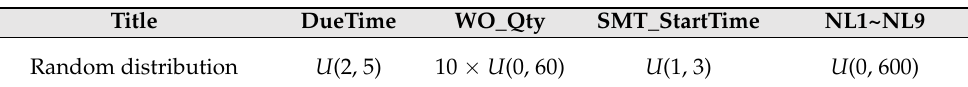
Table 3. Test data generation